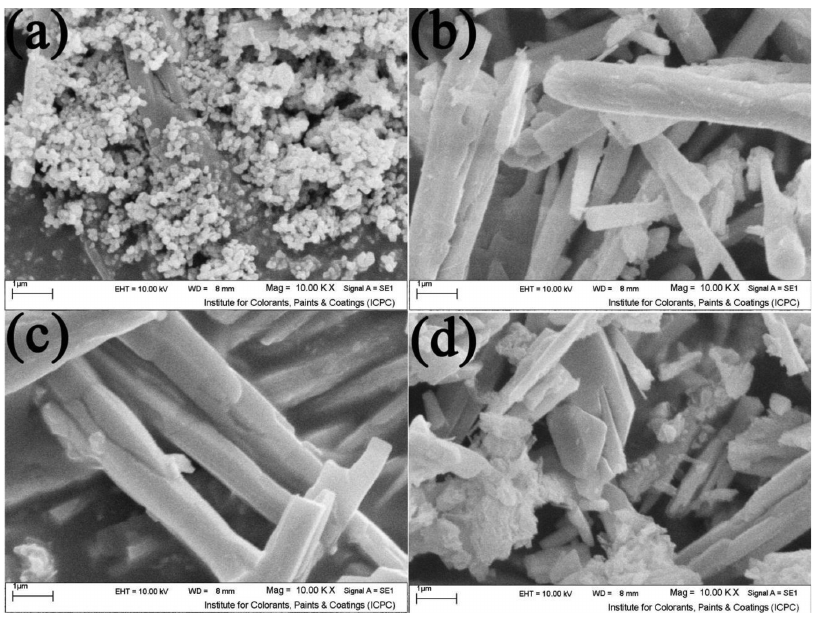
Figure 6: SEM image of sample no. 11 –